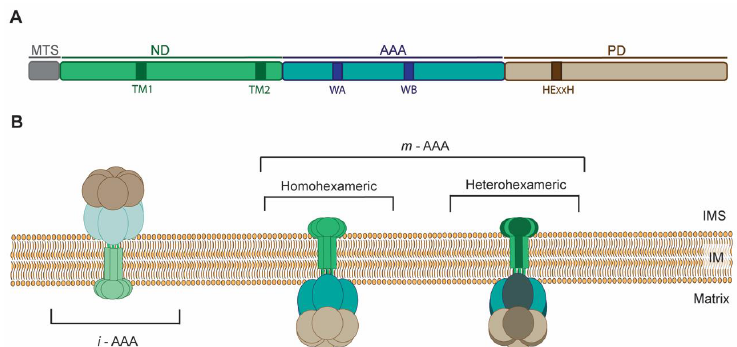
Figure 1. Structural characteristics and organization of AAA (ATPases associated with diverse cellular activities) proteases in mitochondrial inner membrane. ( A ) Domain architecture of AAA proteases. Subunit of m -AAA protease is presented on the scheme. In contrast to m -AAA, subunit of i -AAA protease in the N-terminal domain (ND) contains only one transmembrane region (TM). MTS, mitochondrial targeting sequence; AAA, AAA domain; PD, proteolytic domain; WA and WB, Walker A and Walker B motifs. ( B ) Topology of oligomers of AAA proteases in the inner mitochondrial membrane. IMS, intermembrane space; IM, inner membrane.